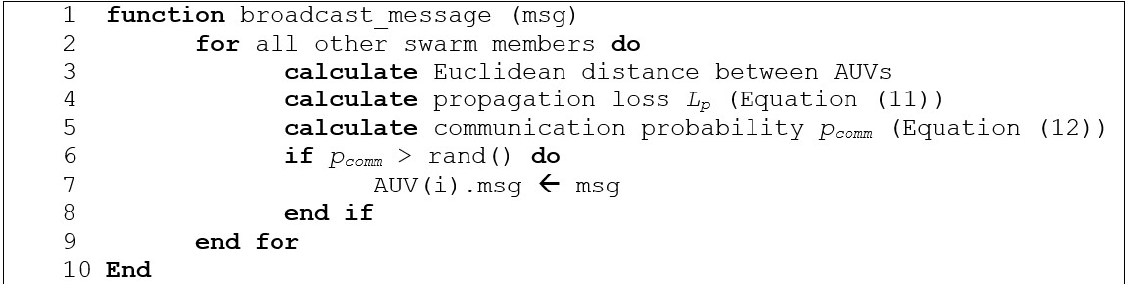
Figure 11. Pseudocode of error influenced communication between autonomous underwater vehi- cles (AUVs).